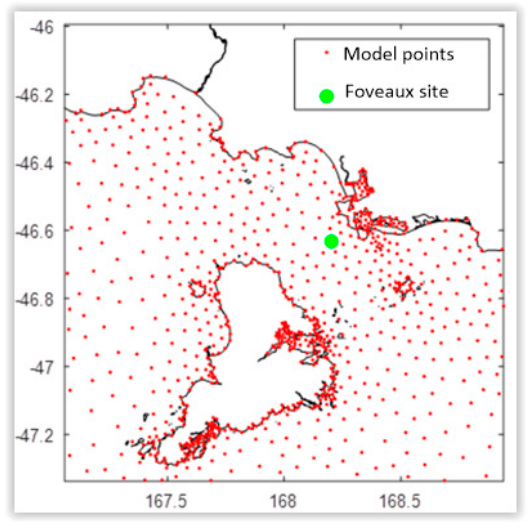
Figure 4. Tidal current model points near Stewart Island from NIWA.